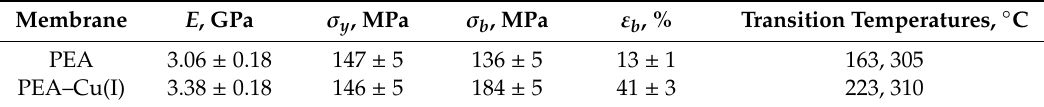
Table 3. Mechanical and thermal properties of